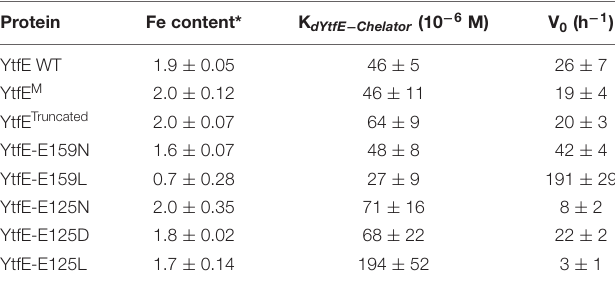
TABLE 1 | Iron content, dissociation constants and initial iron release rates of E. coli YtfE and variants.